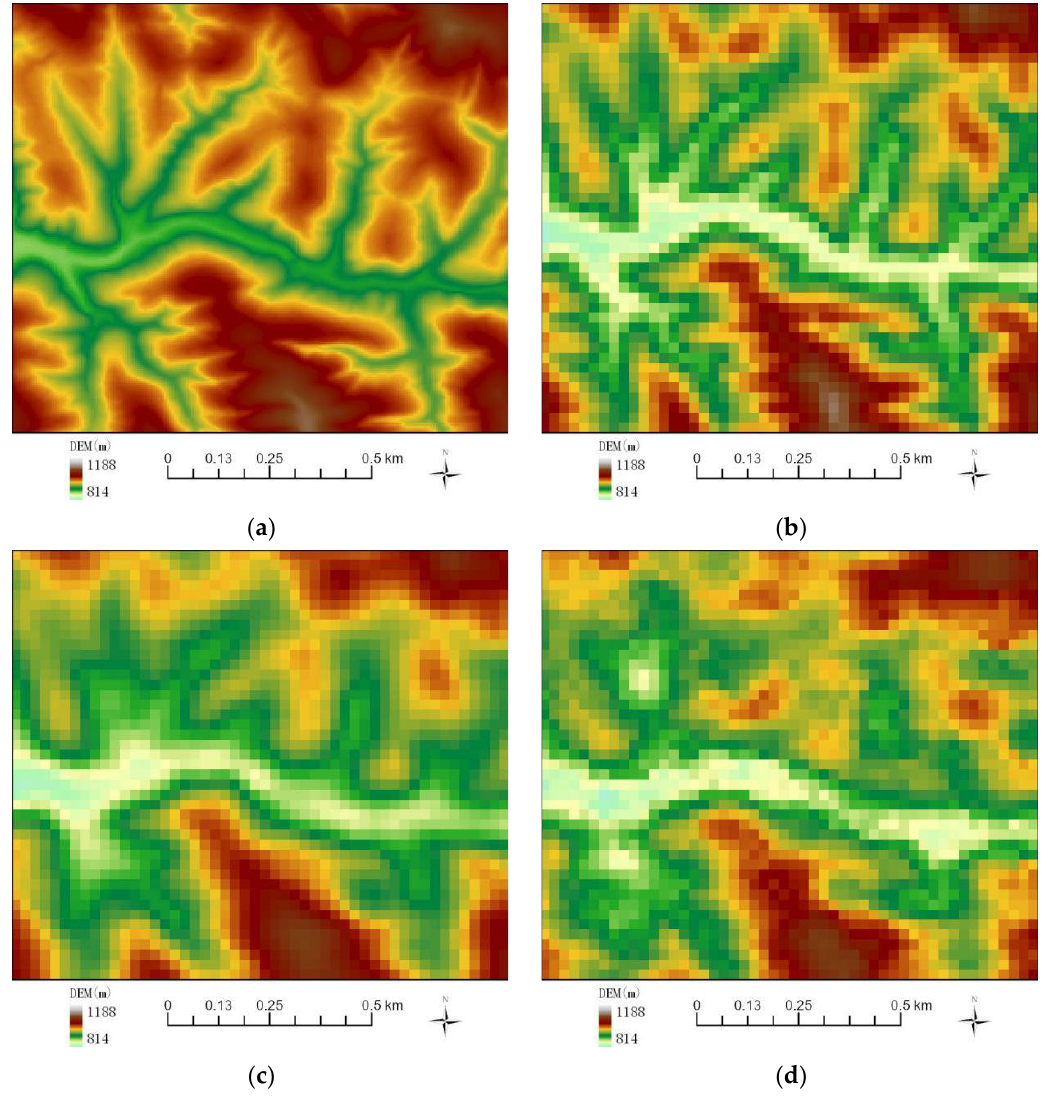
Figure 2. A comparison of four kinds of DEM data: ( a ) 5 m DEM; ( b ) ALOS DEM; ( c ) SRTM DEM; ( d ) ASTER DEM.